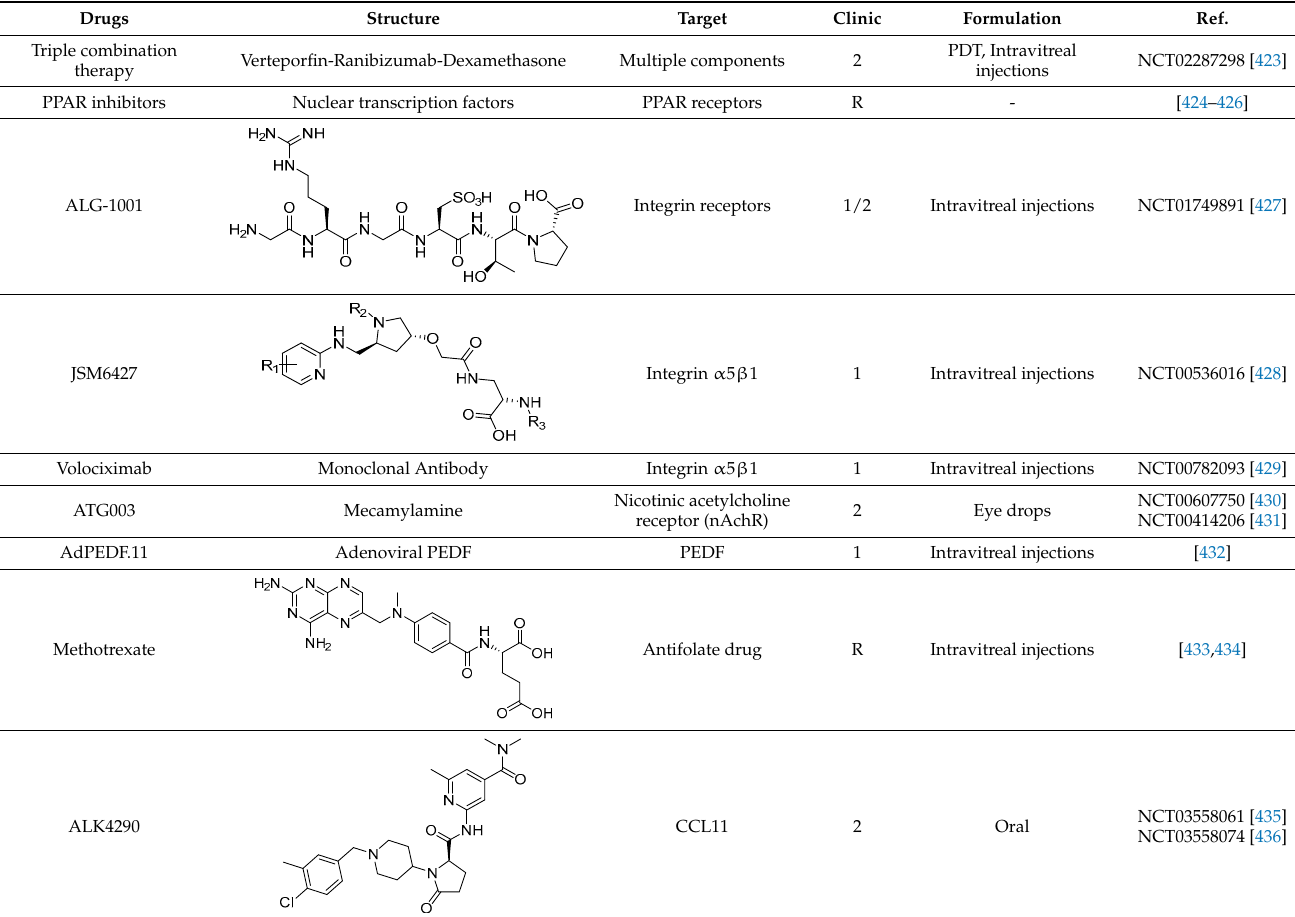
Table 10. Non antiangiogenic treatments studied for exudative AMD.